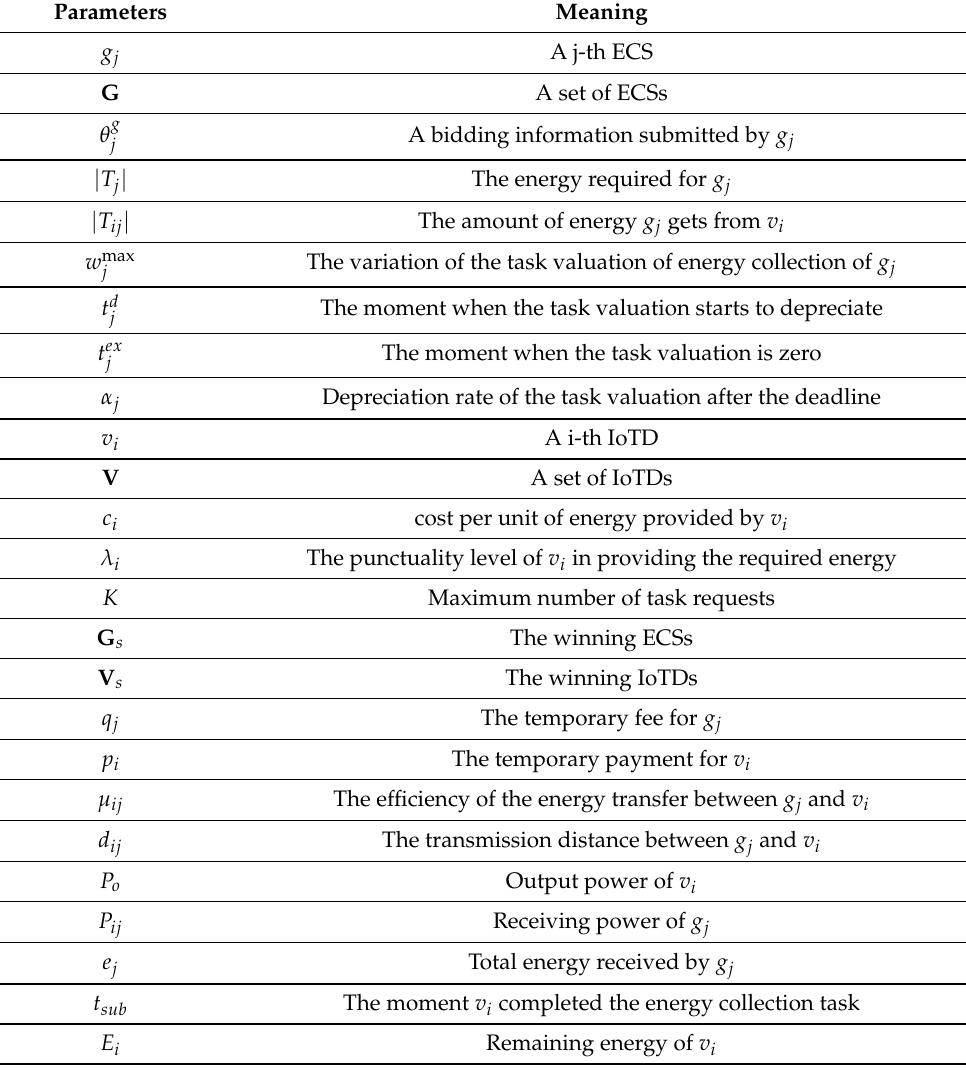
Table 2. System Parameters.